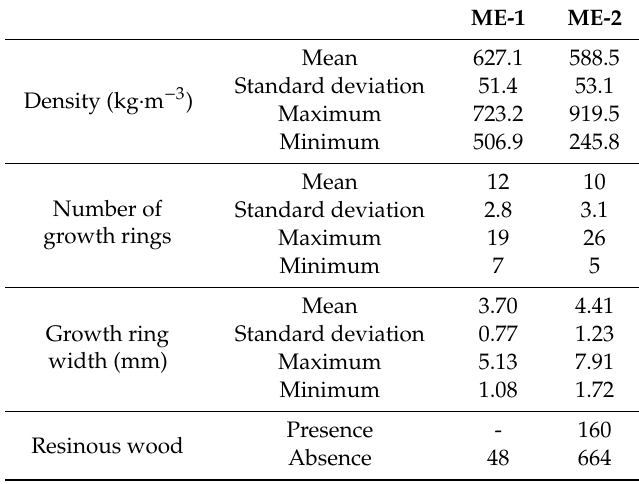
Table 5. Density, number of growth rings, growth ring width and pieces with resinous wood by visual